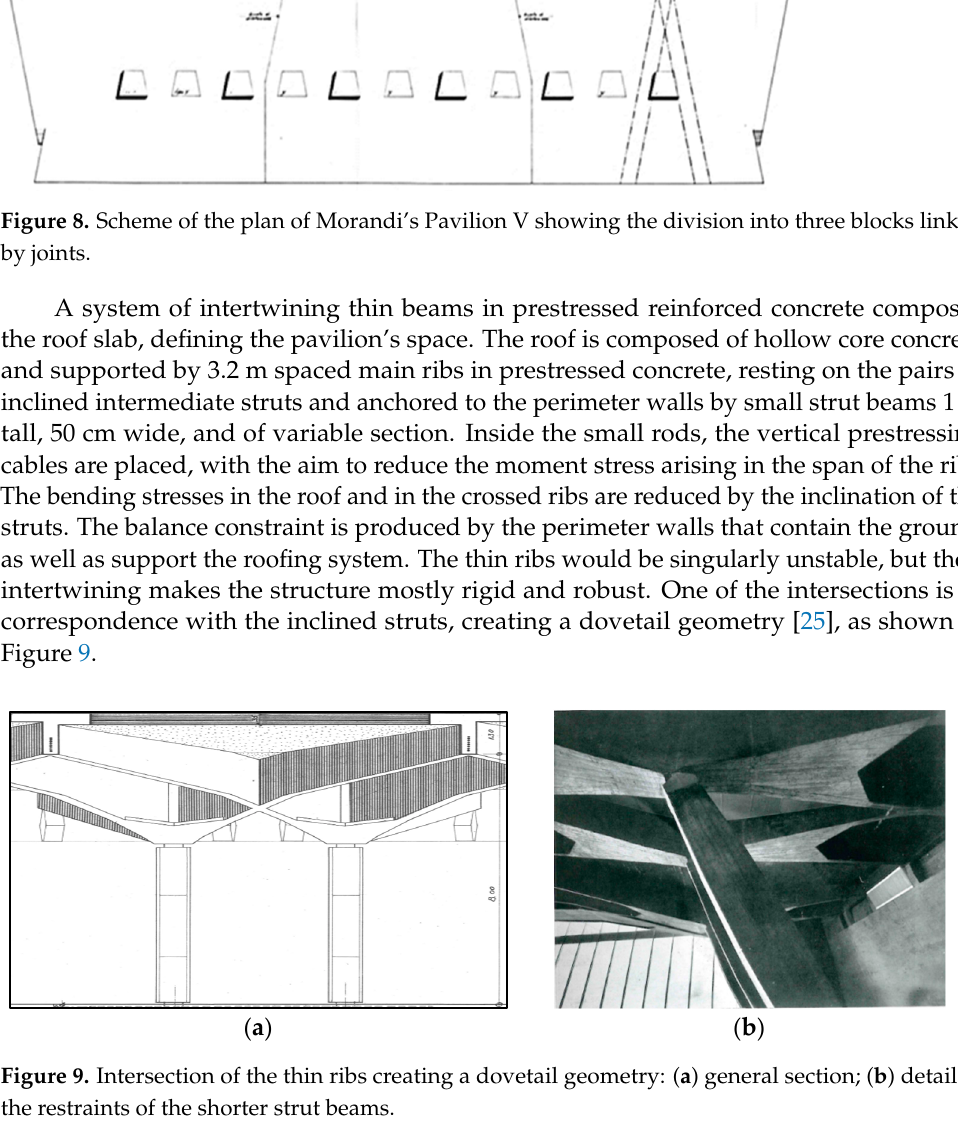
Figure 7. Interior view of Morandi’s Pavilion V.